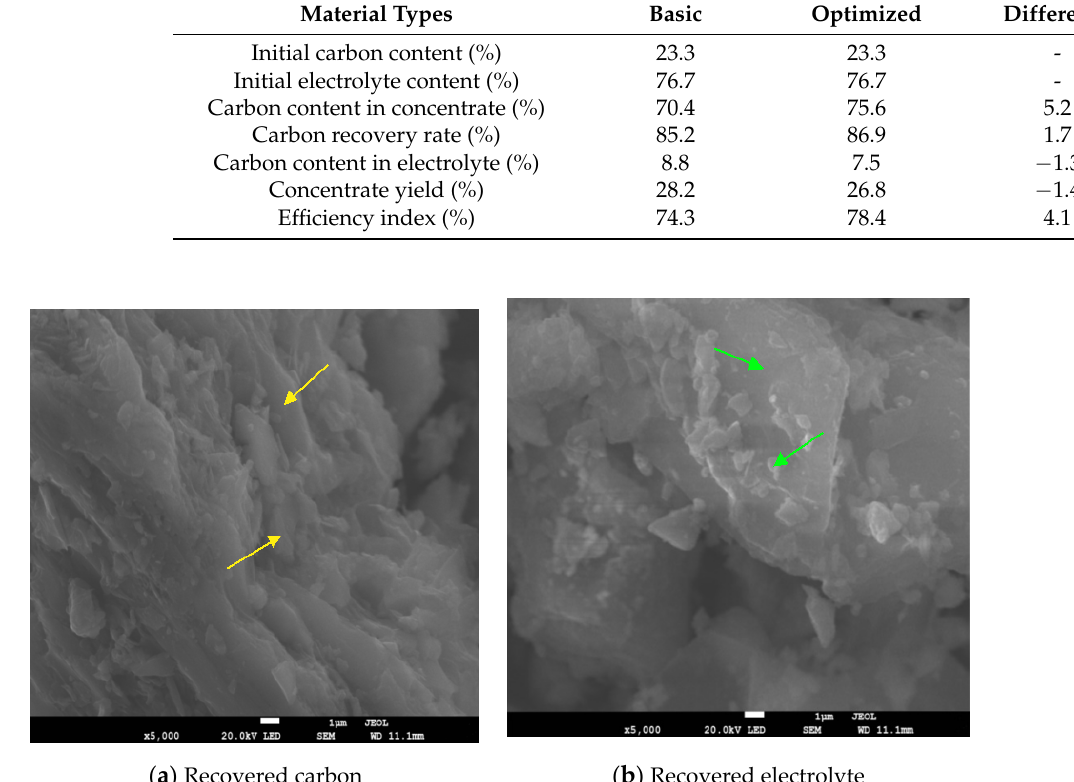
Figure 13. Surface topography of ( a ) recovered carbon and ( b ) recovered electrolyte using SEM. Table 6. Comparison of basic and optimized industrial process experiments.